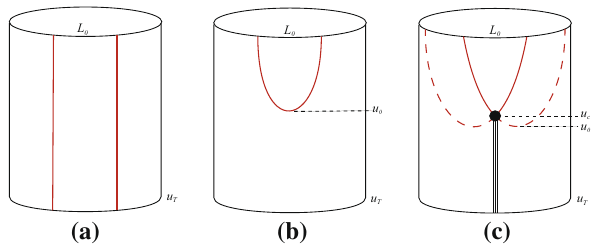
Fig. 1 Different configurations of D8 and D8-branes in the Sakai- Sugimoto model that are dual to the phases of a χ S -QGP, b vacuum and c multiquark phase. The asymptotic separation of D8-branes is fixed to L 0 = 1.